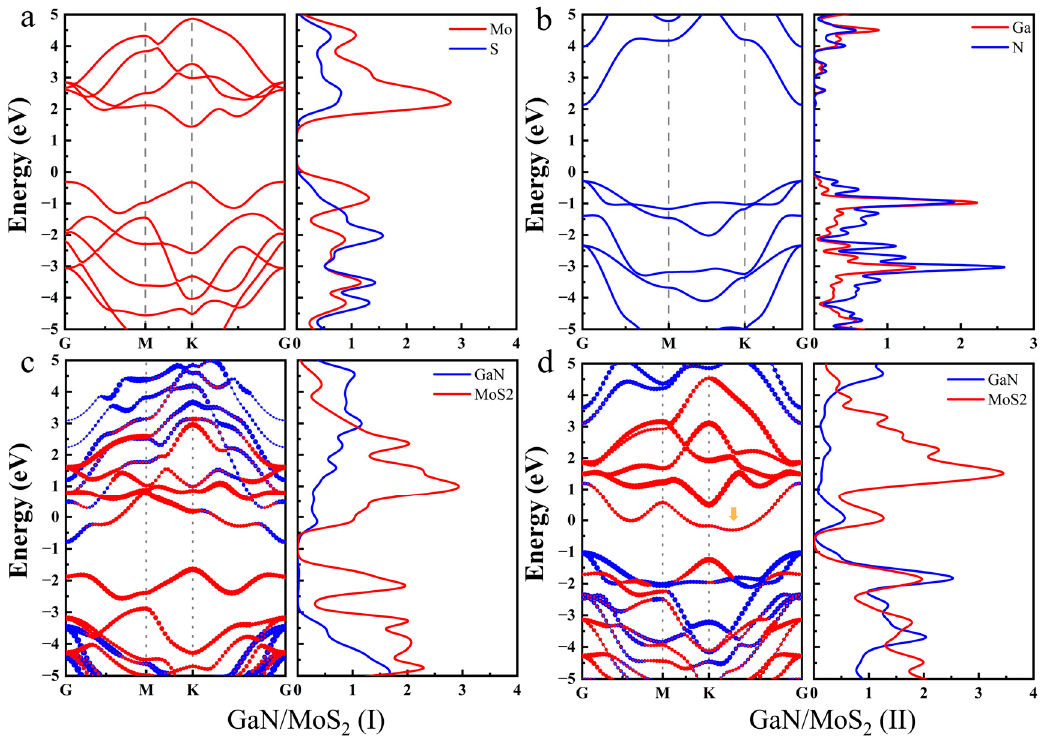
Figure 2. Band structures and local density of states of ( a ) MoS 2 , ( b ) GaN, ( c ) GaN/MoS 2 (I), and ( d ) GaN/MoS 2 (II) heterostructures, respectively. The Fermi level is set as the zero reference.